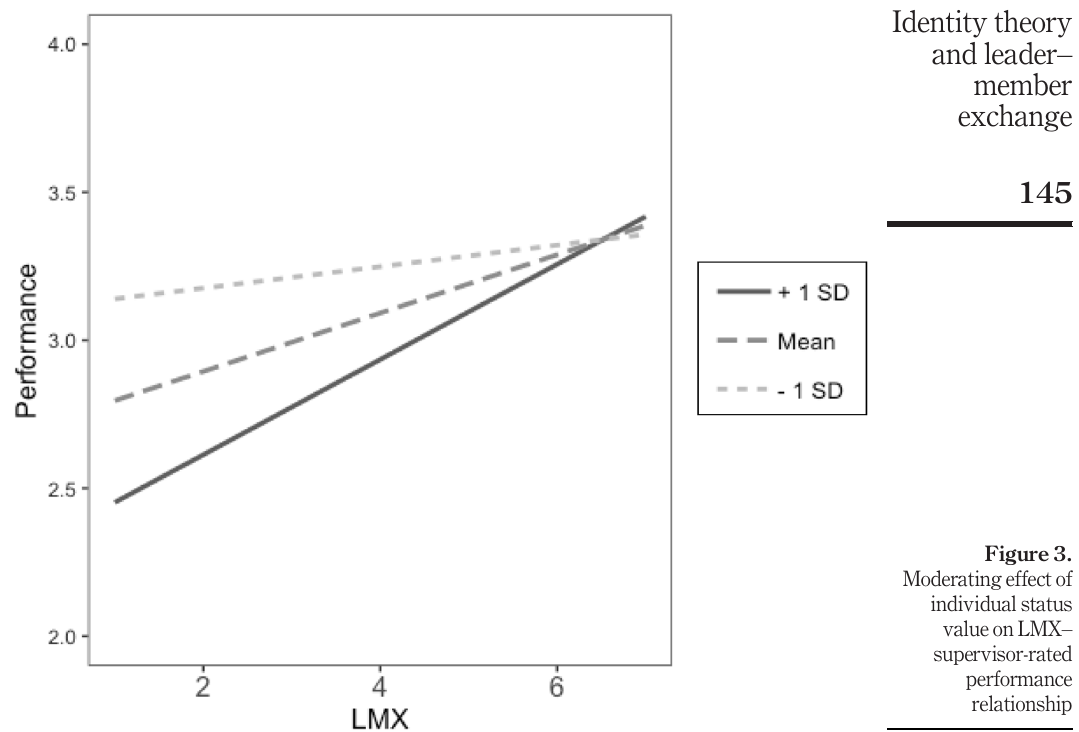
Figure 3. Moderating effect